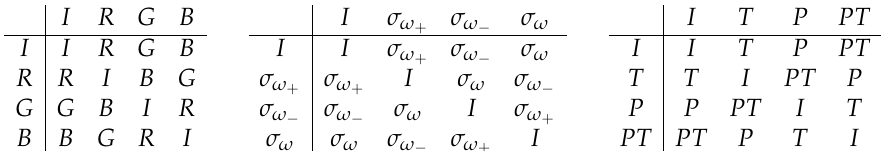
Figure 1. The Cayley table of the Klein 4-group. On the left: the general case, with three colors: R : Red, G : Green, B : Blue. On the middle: case of the discrete subgroup of O ( p , q ) : { I , σ ω On the right: case of the discrete subgroup of the Lorentz group: { I , T , P , PT }